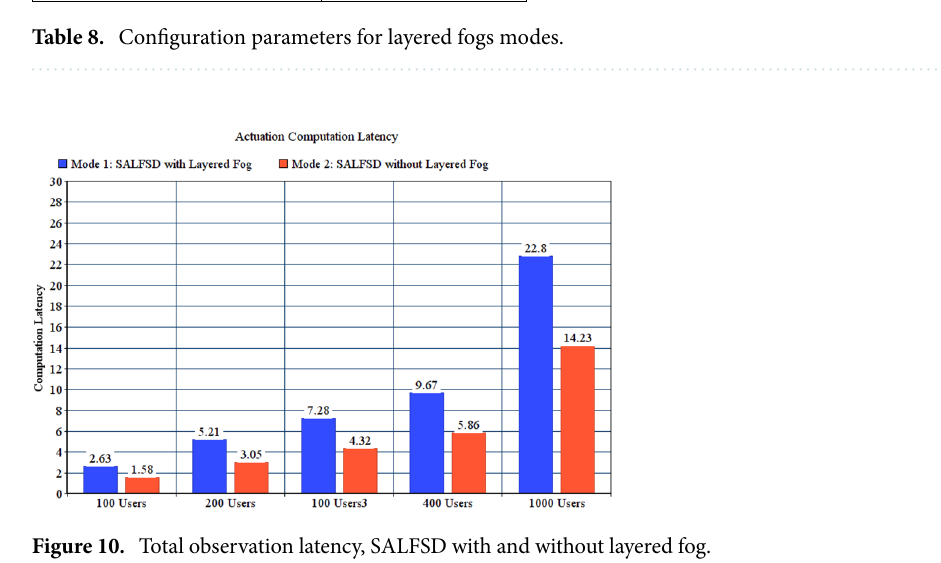
Figure 10. Total observation latency, SALFSD with and without layered fog.